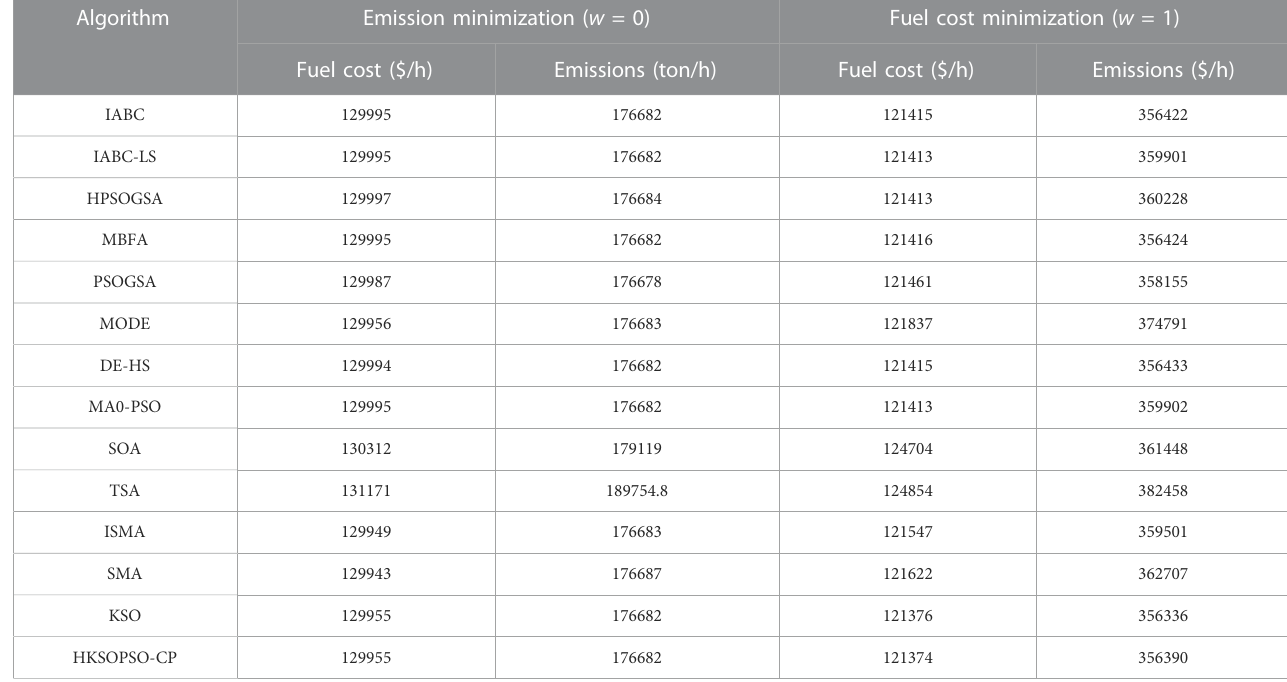
TABLE 11 Case 3 comparison between different algorithms optimizing for fuel cost or emission rate.